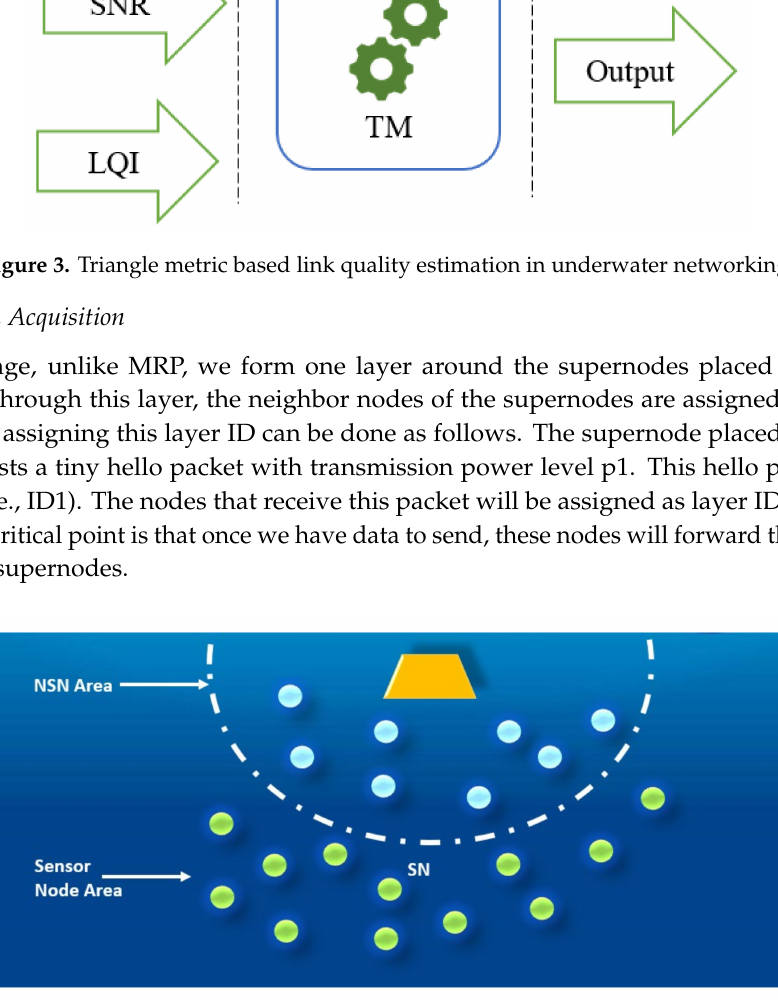
Figure 4. An illustration of assigning layer ID for neighbor of supernode